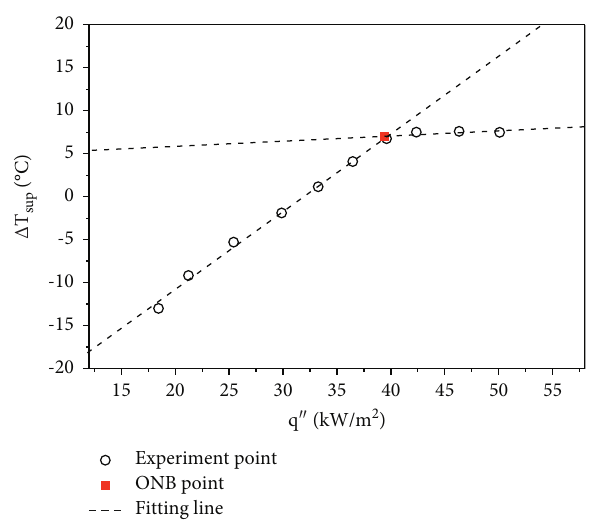
: 70 ° C, G : 100kg/(m 2 · s)). in